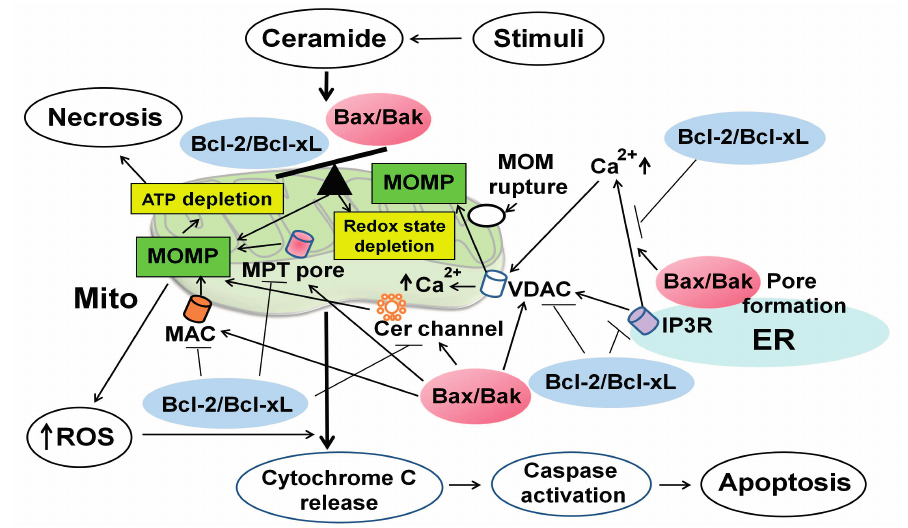
Figure 3. Mitochondria, Bcl-2 family proteins, and reactive oxygen species (ROS) in ceramide-induced apoptosis of renal tubular cells (RTCs). Once ceramide is synthesized and accumulated upon stimuli, it can induce ROS generation and depletion of redox system by inhibiting mitochondrial respiratory chain complexes. Depletion of ATP can switch the cell death from of apoptosis to necrosis. Ceramide enhances the expression and activity of pro-apoptotic Bcl-2 family proteins (e.g., Bax/Bak) and reduces those of anti-apoptotic Bcl-2 proteins (e.g., Bcl-2/Bcl-xL). Ceramide can regulate at least 4 channel/pore-forming complexes that regulate the MOMP: (1) a proteolipid pore, mitochondrial apoptosis-induced channel (MAC), formed by oligomerization of Bax and Bak mediated by tBid in the MOM; (2) a lipid channel formed by ceramide in the MOM; (3) a voltage-dependent anion